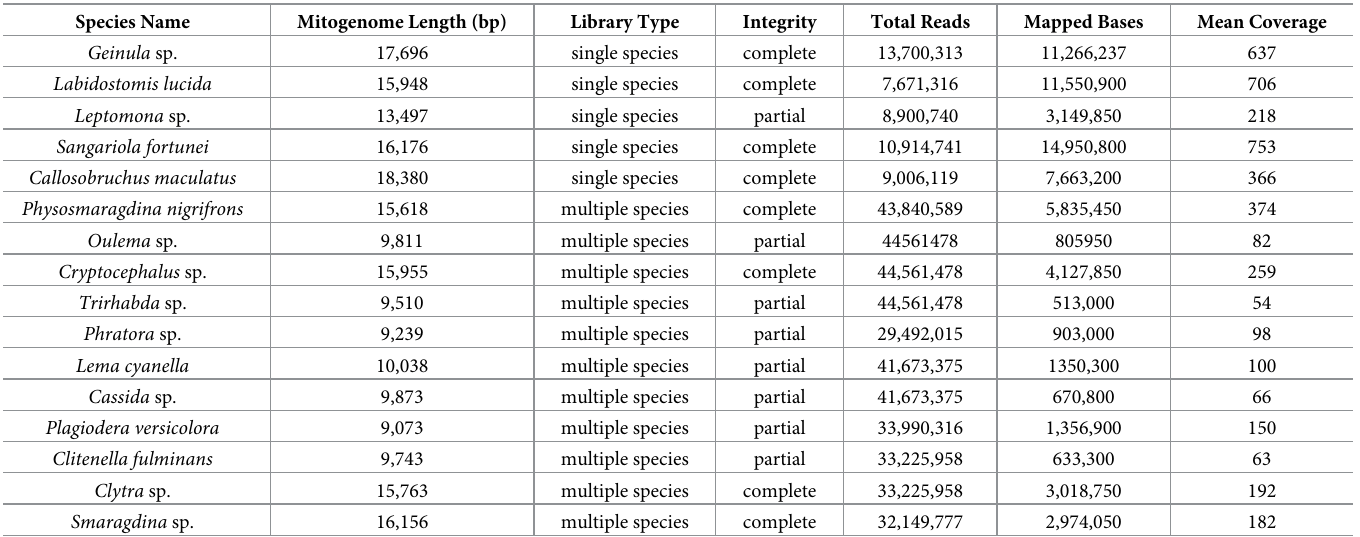
Table 1. Statistics associated to the sequencing of